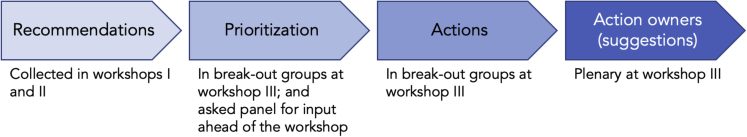
Approach to Prioritizing Recommendations